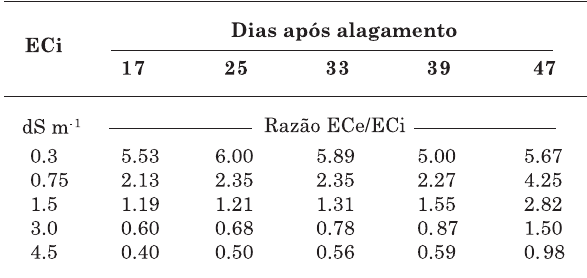
Table 1. Ratio between the effective electrical conductivity (ECe) and electrical conductivity of the water layer (ECi), throughout the rice development, according to ECi